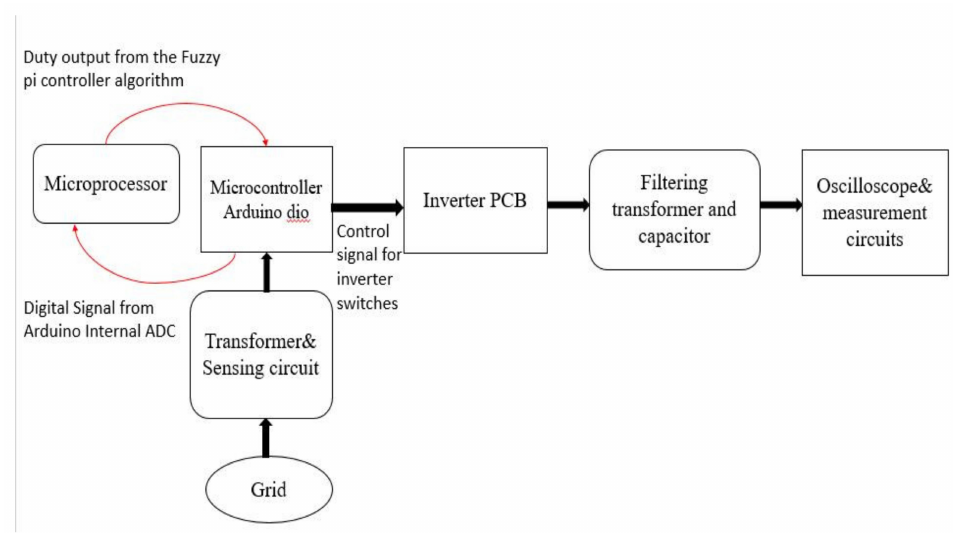
Figure 14. Block diagram of the proposed hardware.